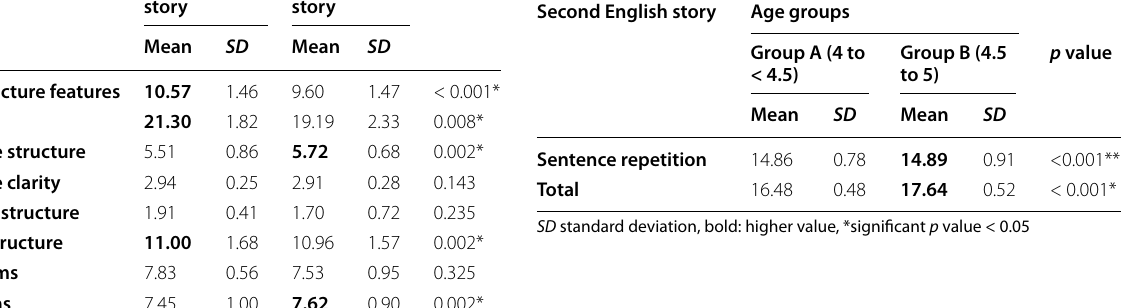
Table 12 Comparison between the scores of Arabic and English Narration Tests in the second story (the boy and his grandpa) in age group A